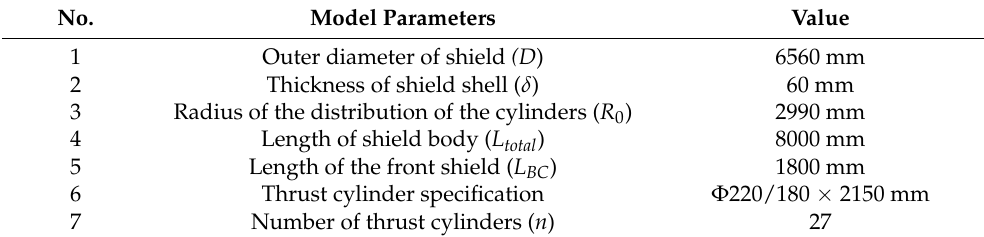
Table 1. The structure and dimension information of the model.